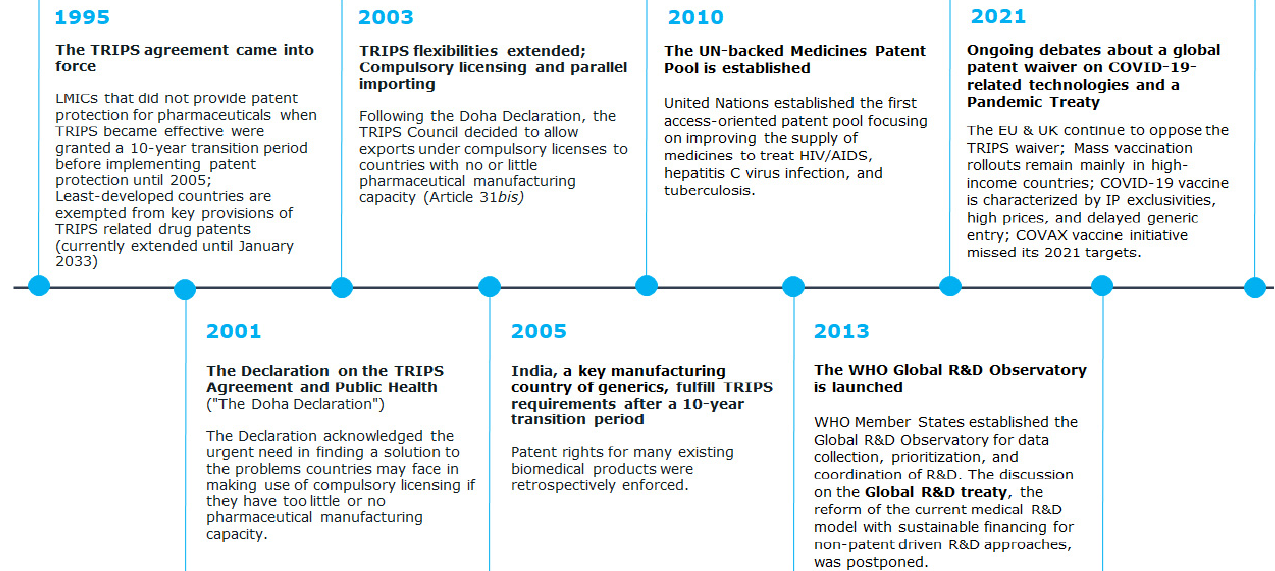
Figure 1. Timeline of global agreements and initiatives related to IP and access to medicines.